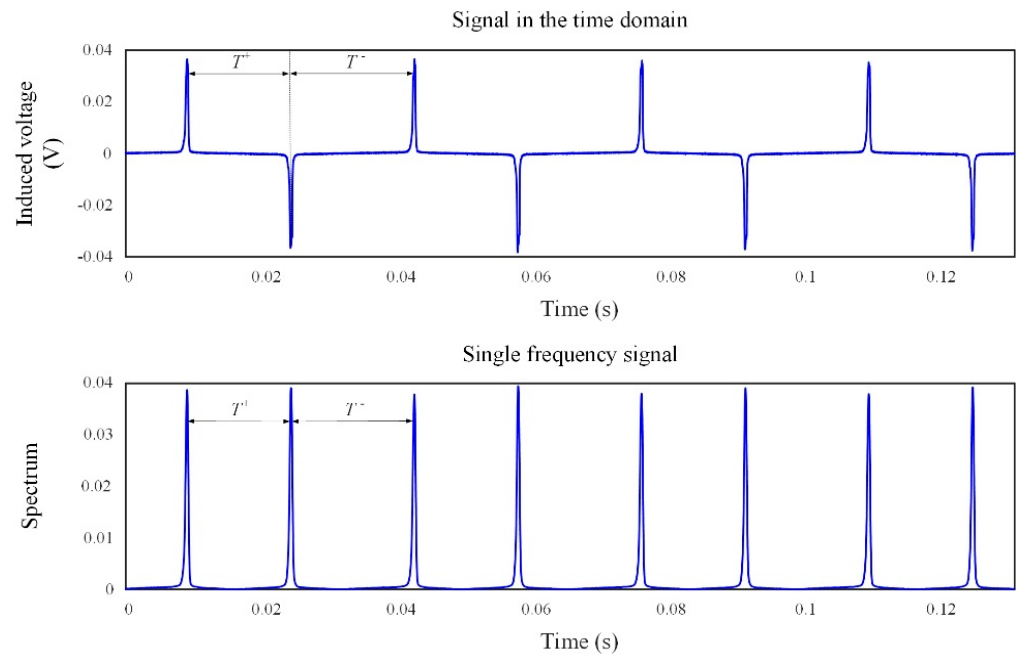
Figure 4. Output spiking signal in the time domain (upper, @30 Hz) and time–frequency transformation of the output spiking signal (nether, f = f 0 = 30